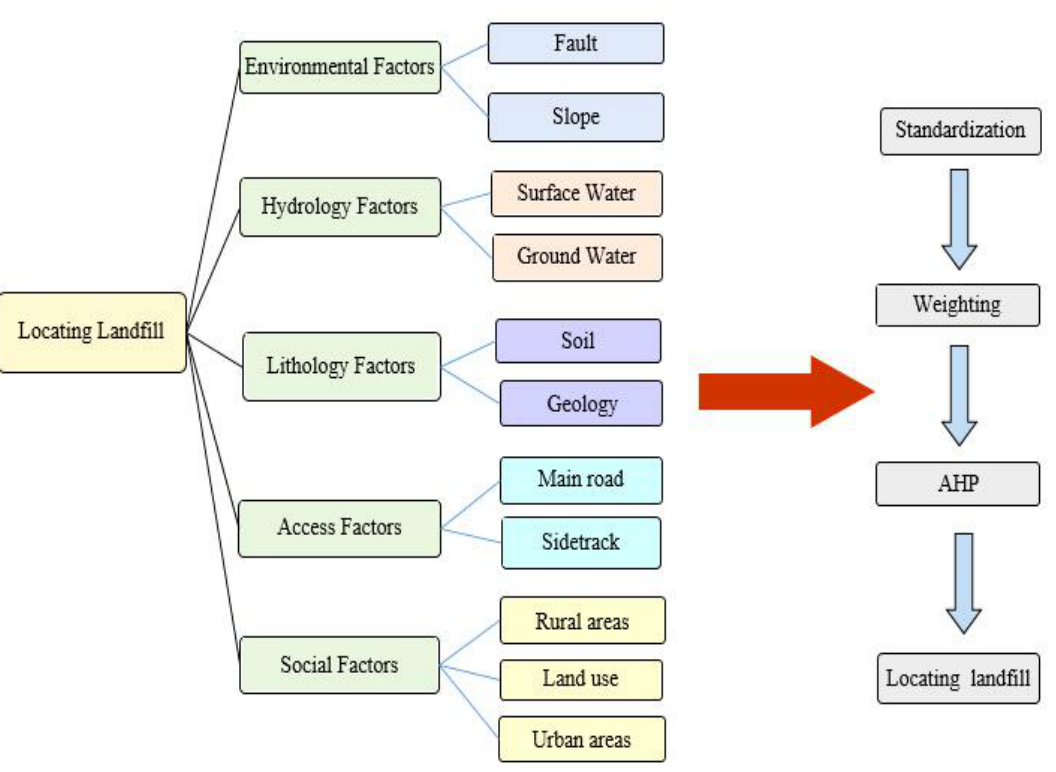
Fig. 2: Framework of the study